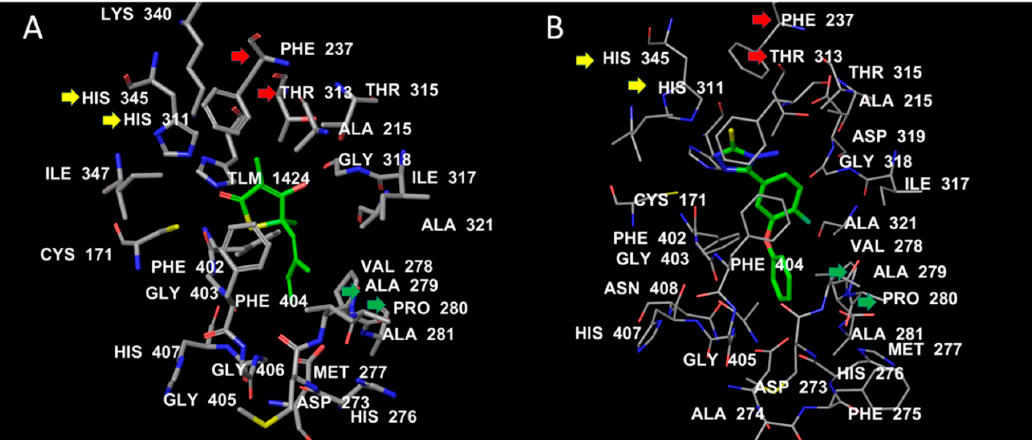
Figure 3. The binding interactions of TLM ( A ) and test compound 1 ( B ) with MTB KasA. The ligand hydrocarbons are displayed in green, while the protein residues are colored by atom type, where carbons are white, nitrogen is blue, and oxygen is red. The labels of the active-site residues are displayed by residue number.